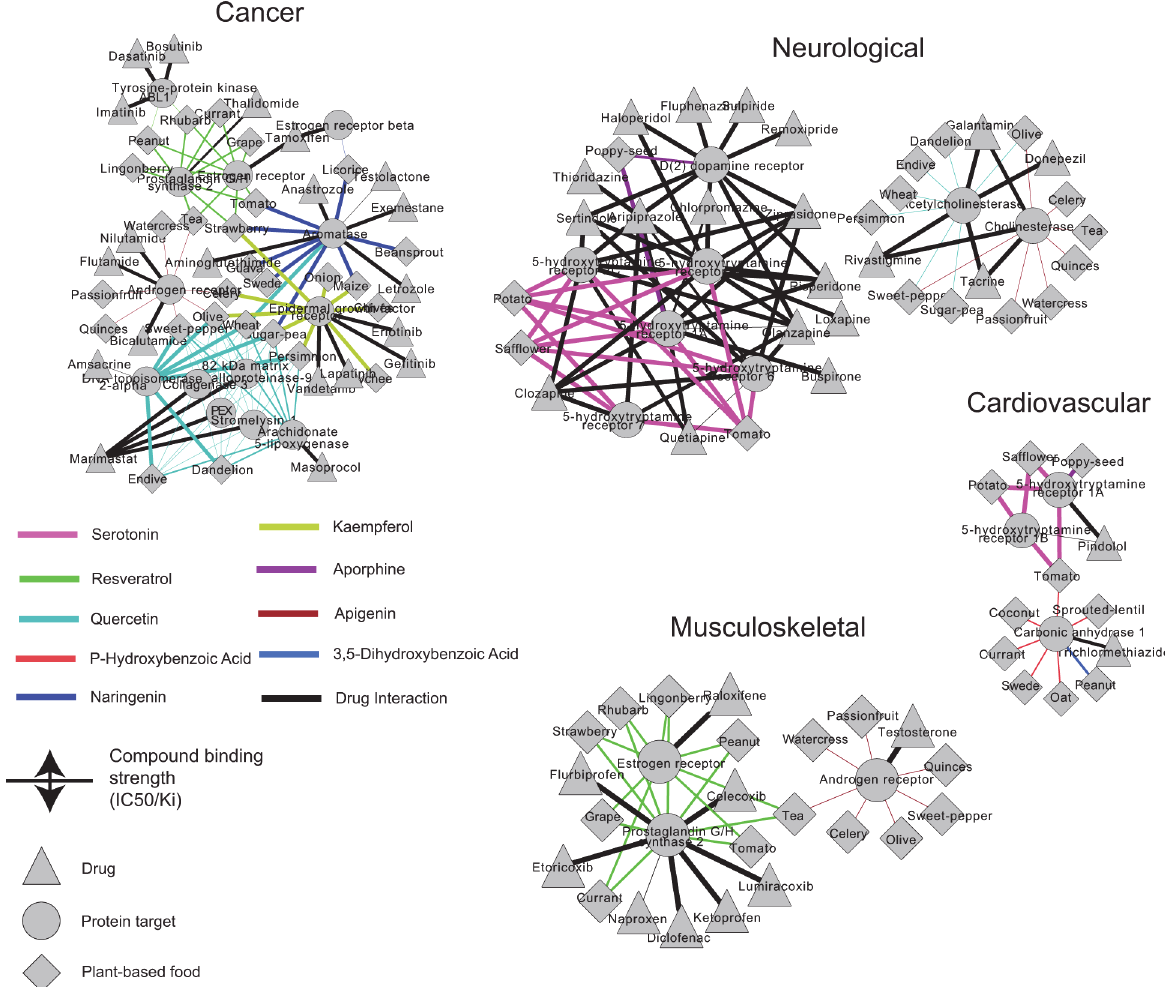
Fig 3. Disease-specific networks of drug-food interactions on proteins affecting drug pharmacodynamics. Node shape denotes drug target (circle), drug (triangle) and food (diamond). Edge color highlights the food compound (phytochemical) that shows the highest binding activity to the effect target. Edge width denotes the biological activity (Ki, IC50) and ranges between 1nM to 1000 nM. For visualization purposes, only 3 drugs and 3 foods with the highest biological activities are shown for each drug target, while the complete data are provided as supplementary material (S3 Table).